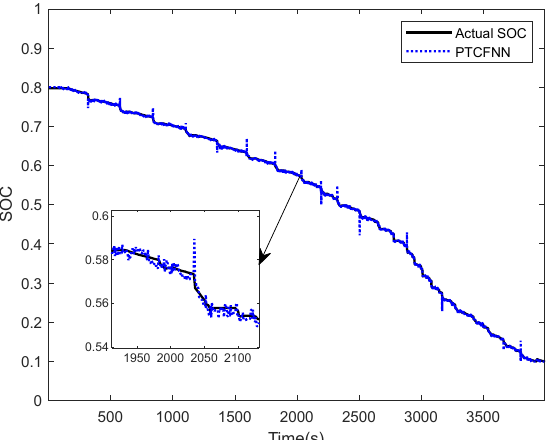
14 of 18 Figure 16. Measured voltage during dynamic current. 5.3. Robustness Test In order to verify the robustness of the PTCFNN, a 2% random relative error is added to the current measurement and voltage measurement, and the simulation results are shown in Figures 17–20. As can be seen from the simulation results, even when there are measurement errors, although a small part of the SOC estimation results have a deviation